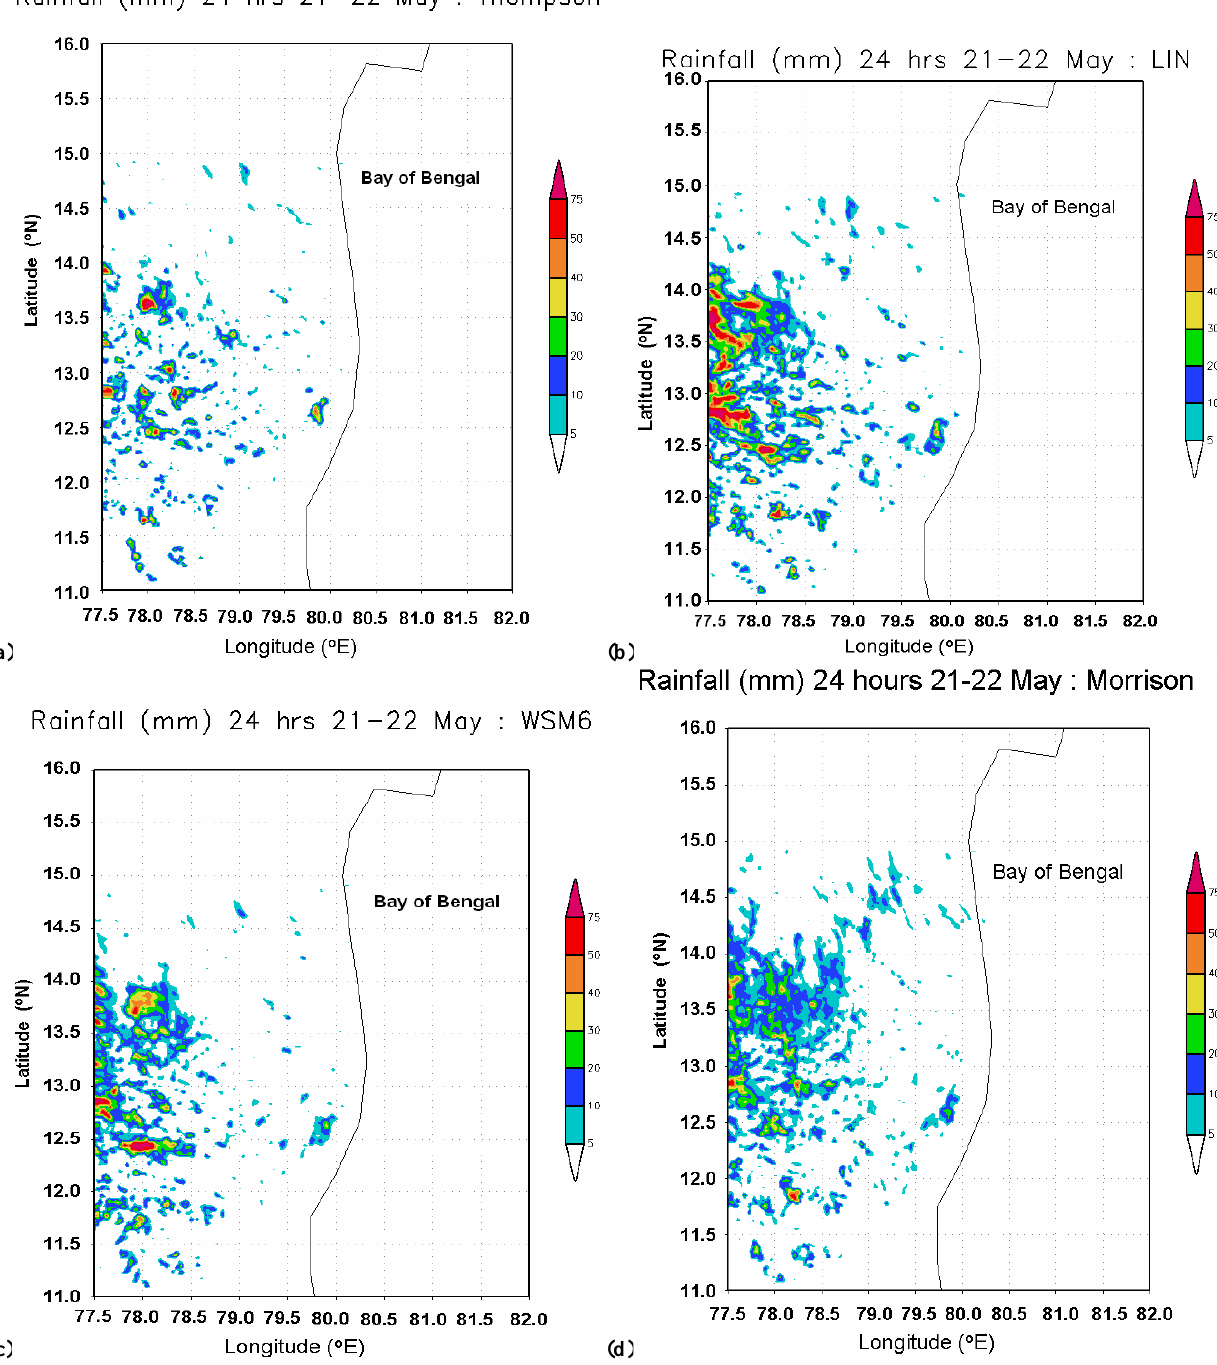
Fig. 8. Accumulated 24h rainfall at 00:00UTC on 22 May 2008 simulated by the model with four different MP schemes (a) Thompson, (b) Lin, (c) WSM6, and (d)